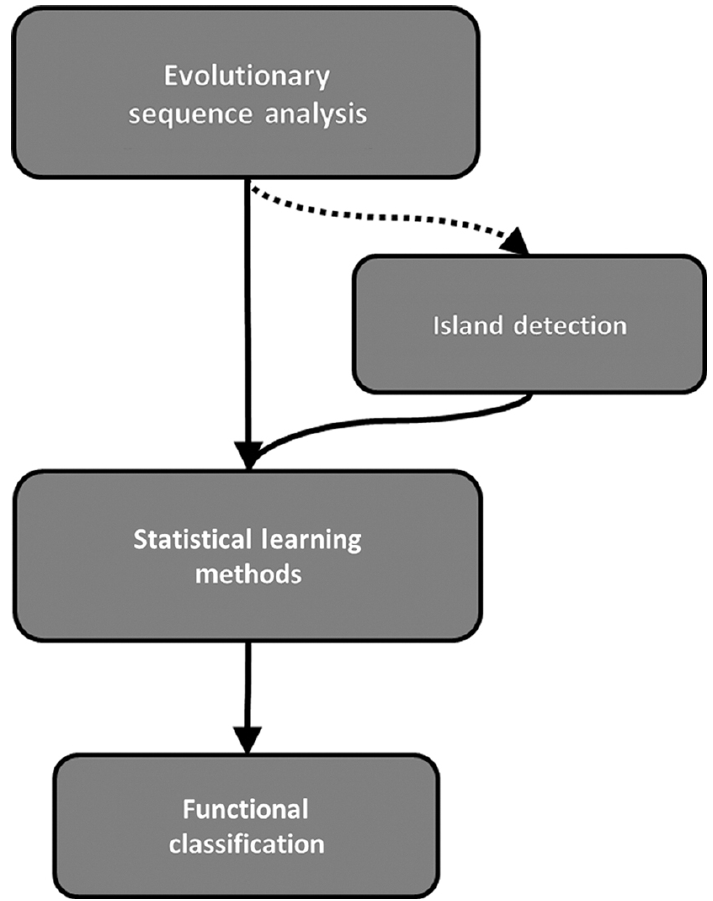
Figure 1: LiSSI pipeline. LiSSI is divided into four modules. After data acquisition (GenBank or locally), a standard run involves: the definition of groups of putative homologous genes (evolutionary sequence analysis), followed by island detection and identification of the most discriminant islands for a given lifestyle (statistical learning methods). Further, functional classification can be used to search for protein domains in the selected genes/islands. Full lines represent mandatory steps, dotted lines represent optional